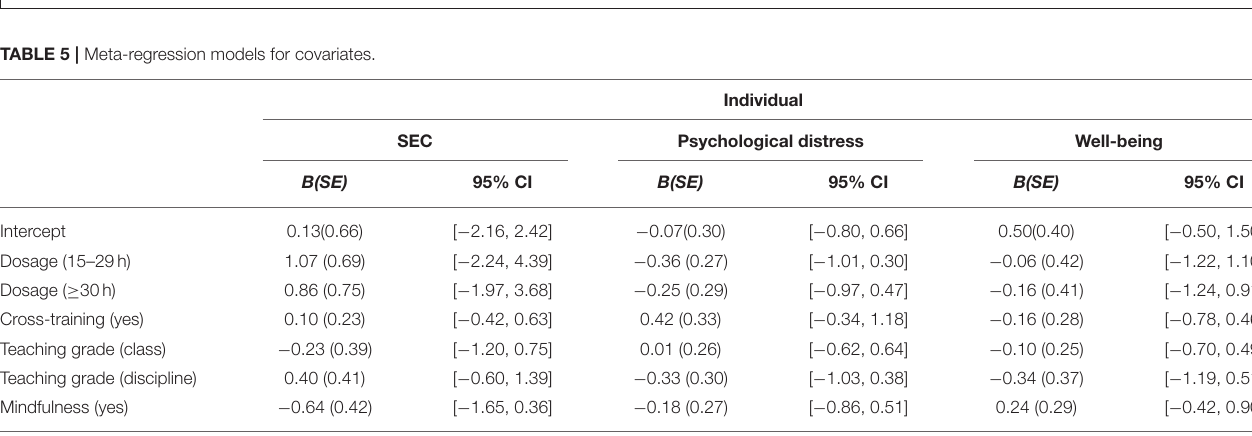
FIGURE 2 | Forest plot with weighted average effects of the five accessed domains by study of combined interventions.